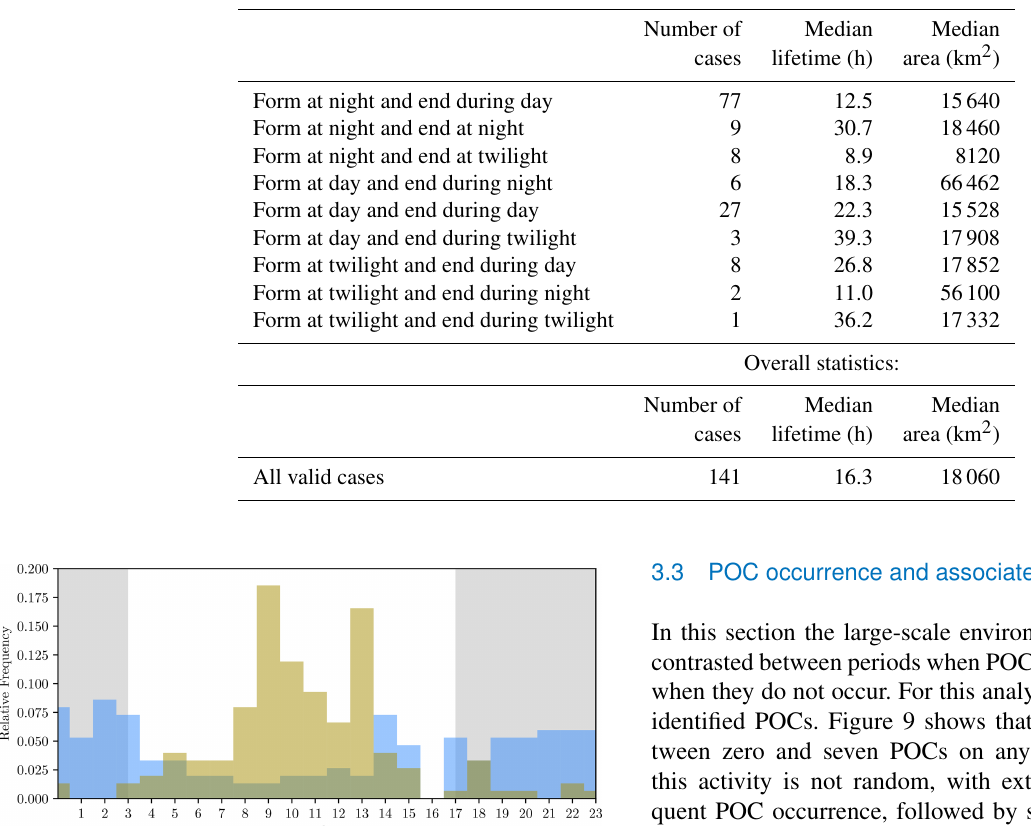
Table 1. Shows total number of cases, median lifetime, and median area of pockets of open-cell stratocumulus (POCs) that start and end during the day, night, or twilight (defined as solar-zenith angles between 65 and 90 ◦ ) for valid POC cases (those that follow a POC along its entire trajectory).